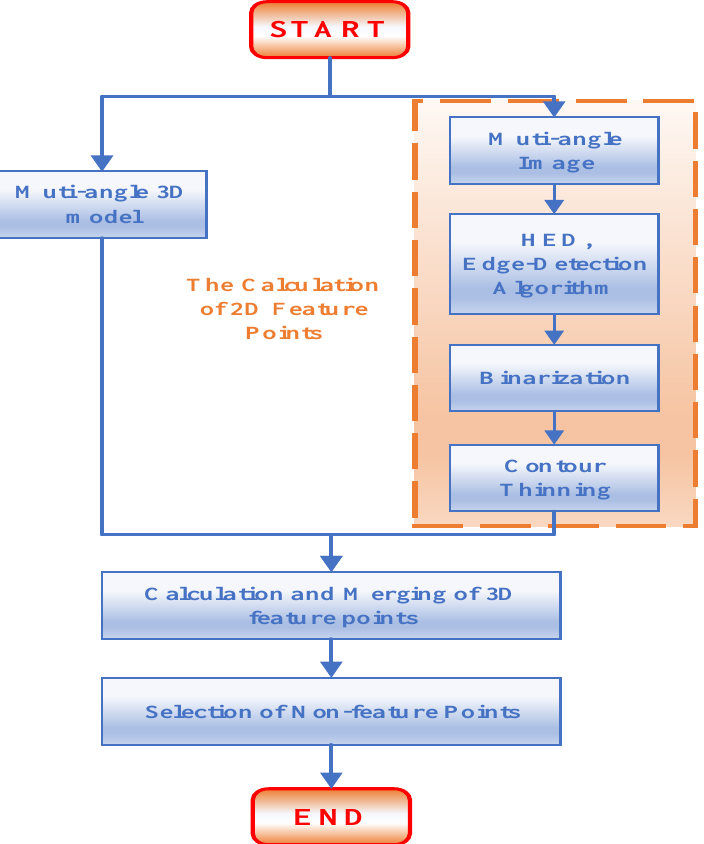
Figure 3. The roadmap of downsampling technology with edge-preserving